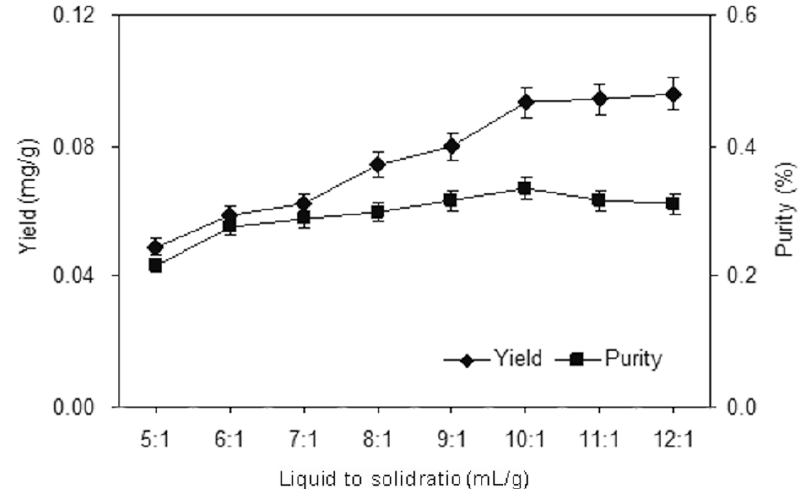
Figure 4. Effect of liquid to solid ratio on the yield and purity of shikonin.